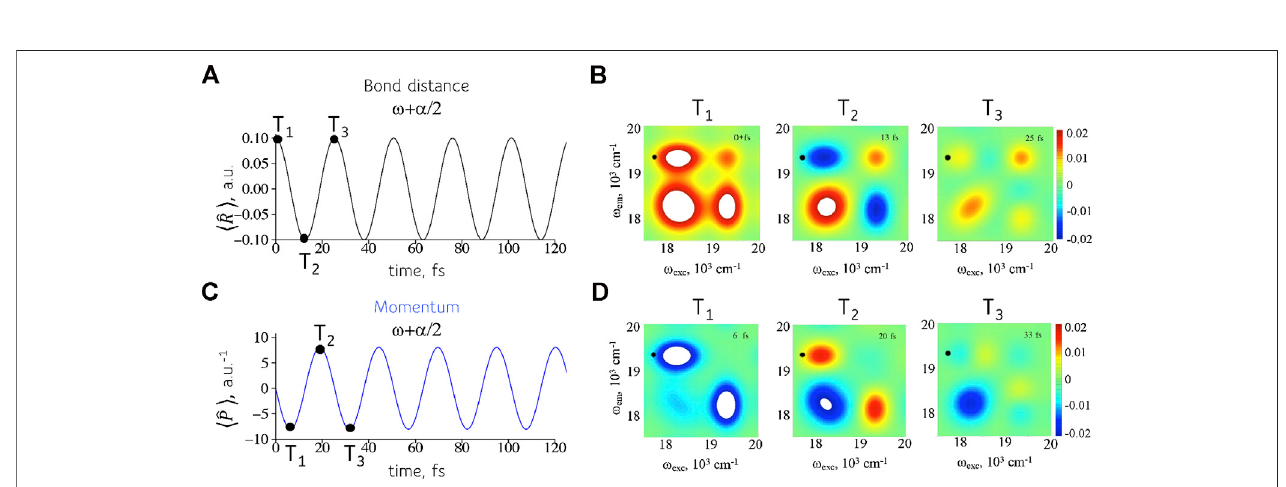
FIGURE5| Readingtwoconjugate variables at thesameposition onthe 2Dfrequencymaps. Left entries: mean position (A) and momentum (C) asgivenby Eq. 6 .Asexpectedthedisplacementismaximalataturningpointofthemotionwhilethemomentumismaximalwhenthewavepacketcrossestheequilibriumpositionofthe oscillator. Right entries: real (B) and imaginary (D) values of the intensities in the frequency map in the frequency range of interest. The values shown are reading at different time intervals T .